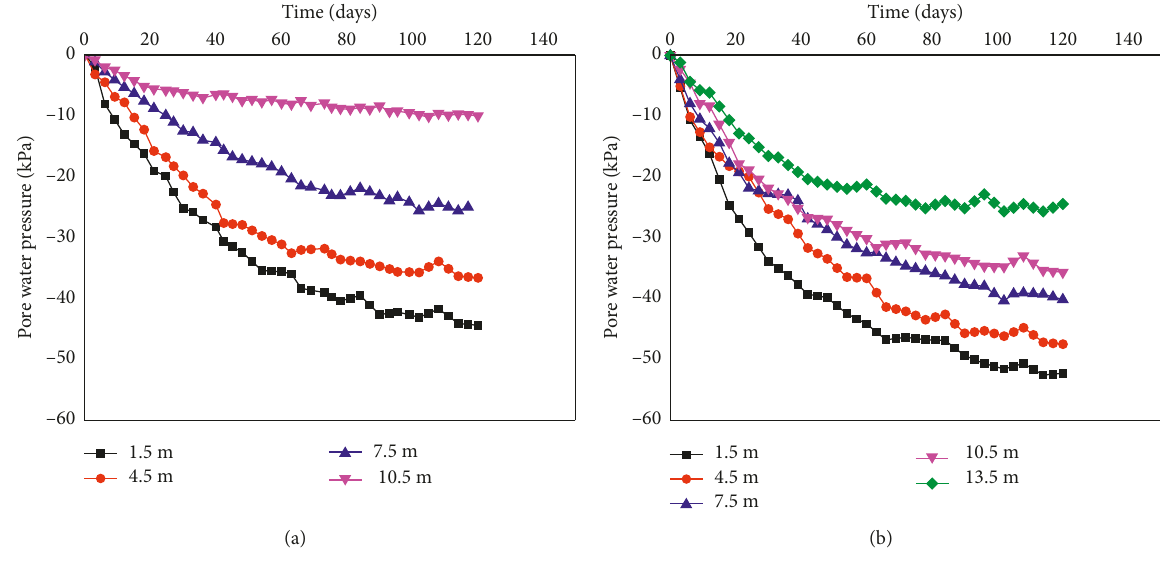
Figure 11: Pore water pressures plotted as functions of time for sections (a) 1 and (b)